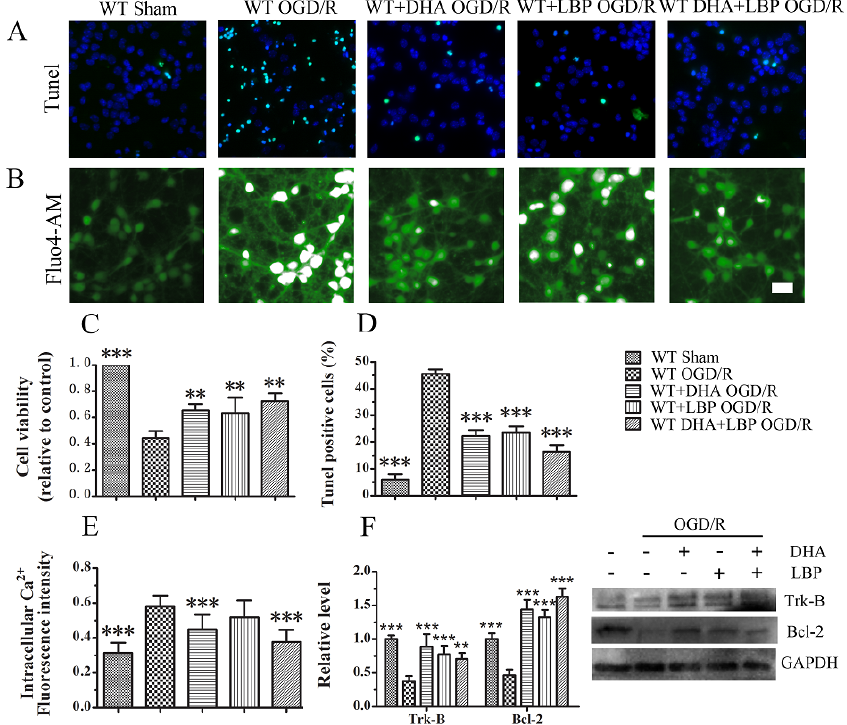
Figure 3. LBP and exogenous DHA (10 μM) significantly prevent OGD/R-induced neuronal apoptosis respectively via intracellular Ca 2+ handling or neurotrophic pathway activation: ( A ) TUNEL staining; ( B ) fluorescent micrographs showing intracellular Ca 2+ levels as stained by the Fluo4-AM dye; ( C ) statistic of cell viability; ( D ) statistic of TUNEL positive cells; ( E ) results of relative fluorescence intensity analysis of intracellular Ca 2+ ; and ( F ) expression levels of Trk-B and Bcl-2 measured by Western blot. Data are presented as mean ± SEM, ** p < 0.01, *** p < 0.001 indicate significant difference compared with the WT OGD group; p < 0.05 indicates significant difference compared with the WT DHA + LBP group ( t -test). Scale bar: 50 μm.